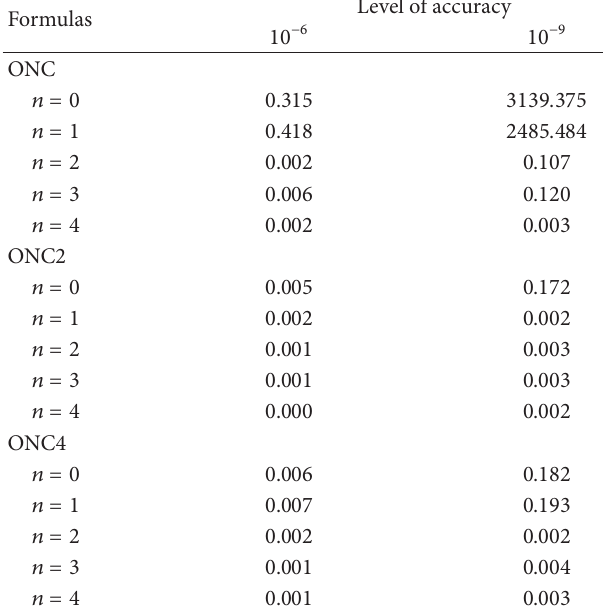
Table 9: Average CPU usage time for evaluating ∫ 𝑥 2 ))𝑑𝑥 .